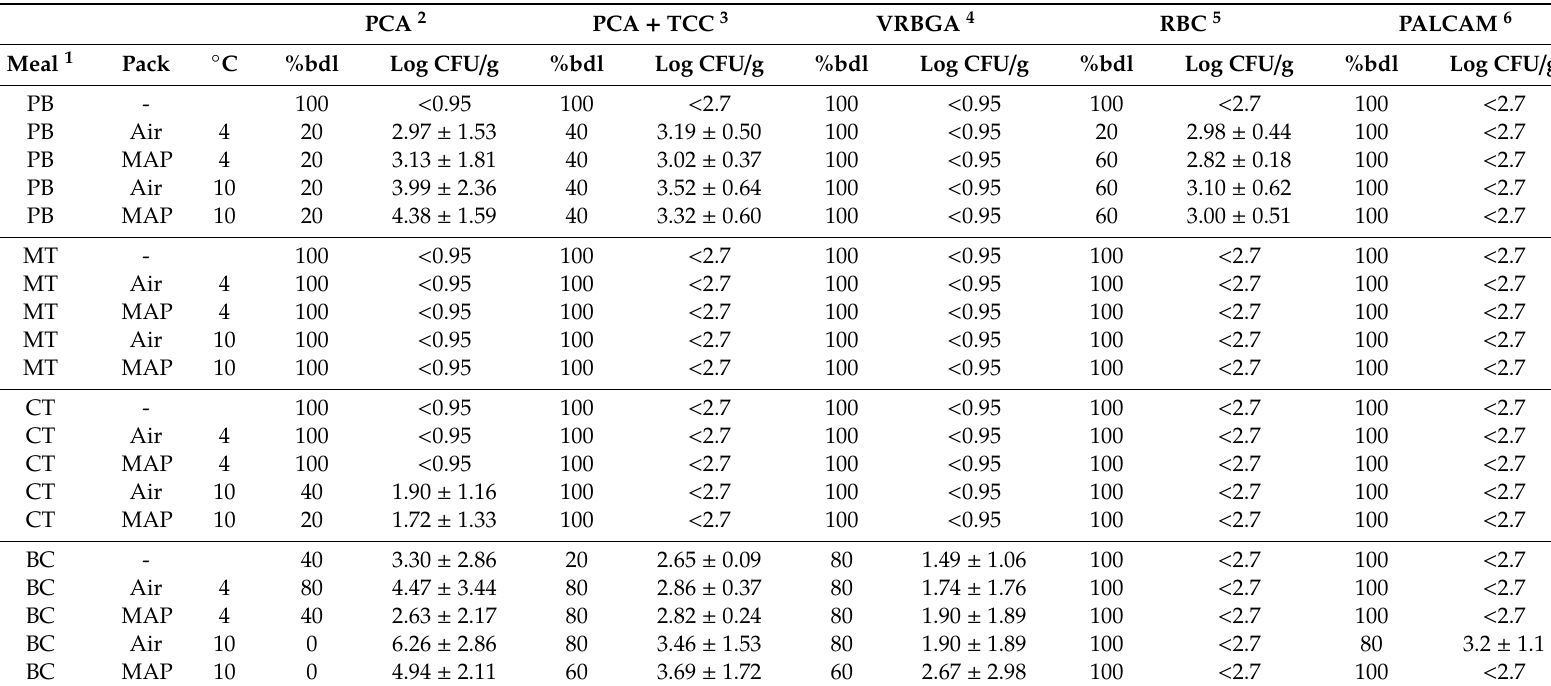
Table 1. Results of microbial counts in the meals 1 stored at 4 or 10 ◦ C in air or Modified Atmosphere Packaging (MAP) for 7 d; mean ± standard deviation of 5 lots (two biological replicates and two technical replicates of each lot); %bdl % of samples below the detection